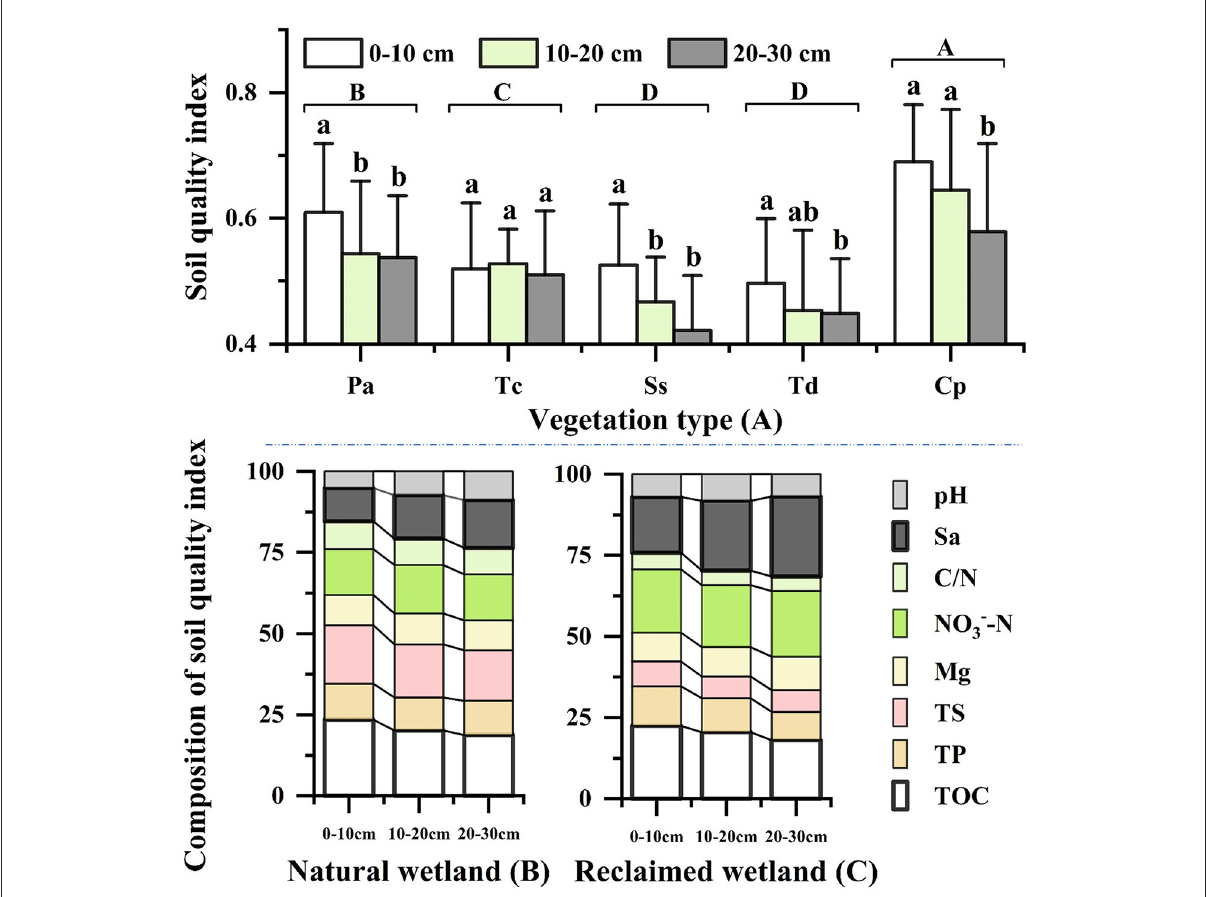
FIGURE2 The SQI values in soil profiles under different vegetation types (A) and the composition of SQI in natural wetland (B) and reclaimed wetland (C) . The vertical bar is standard deviation; different lower letter denotes the significant differences among soil depth for the same vegetation type ( p < 0.05); different upper letter denotes the significant differences among vegetation types in 0–30cm ( p <